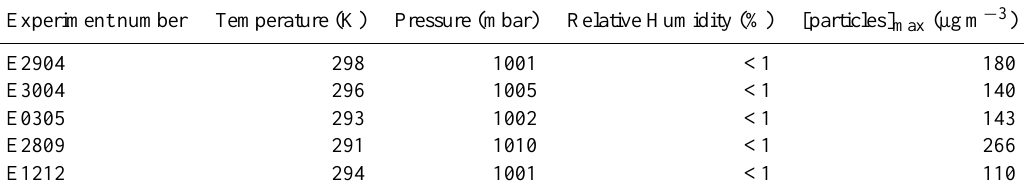
Table 1. Summary of the experimental conditions for each experiment: Temperature, pressure, relative humidity in the chamber and the particles mass concentration injected in the